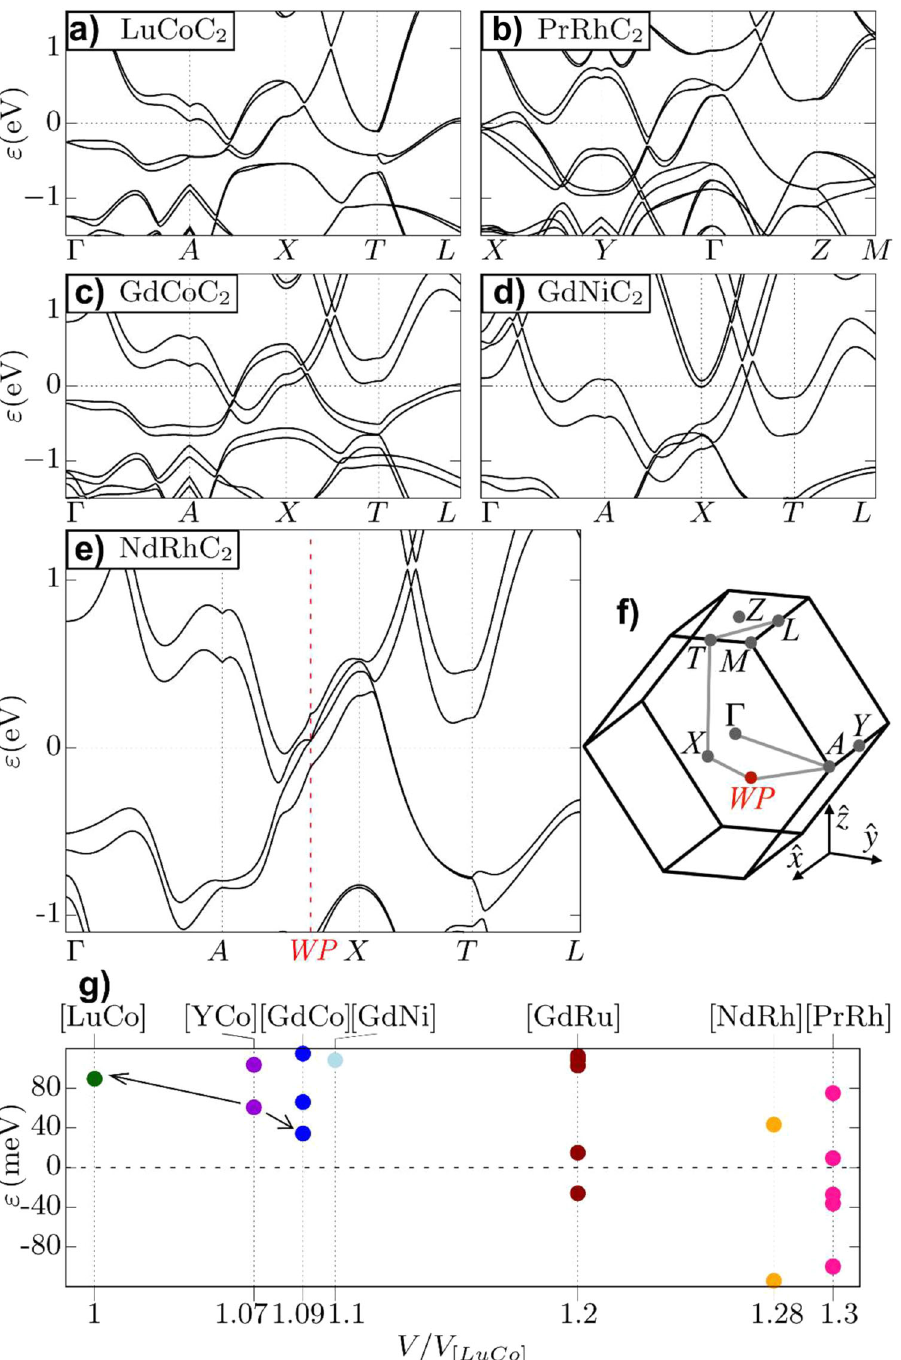
Fig. 2 Electronic properties. a – e Band structures of representative rare-earth dicarbide compounds. f Brillouin zone. The red point corresponds to the Weyl node closest to the Fermi energy for NdRhC 2 and has coordinates (0.665, 0.309, − 0.189) Å − 1 . For b , the chosen high- symmetry points differ due to the AFM doubling of the unit cell. g Energy of the Weyl nodes vs. unit cell volume for all compounds considered in this